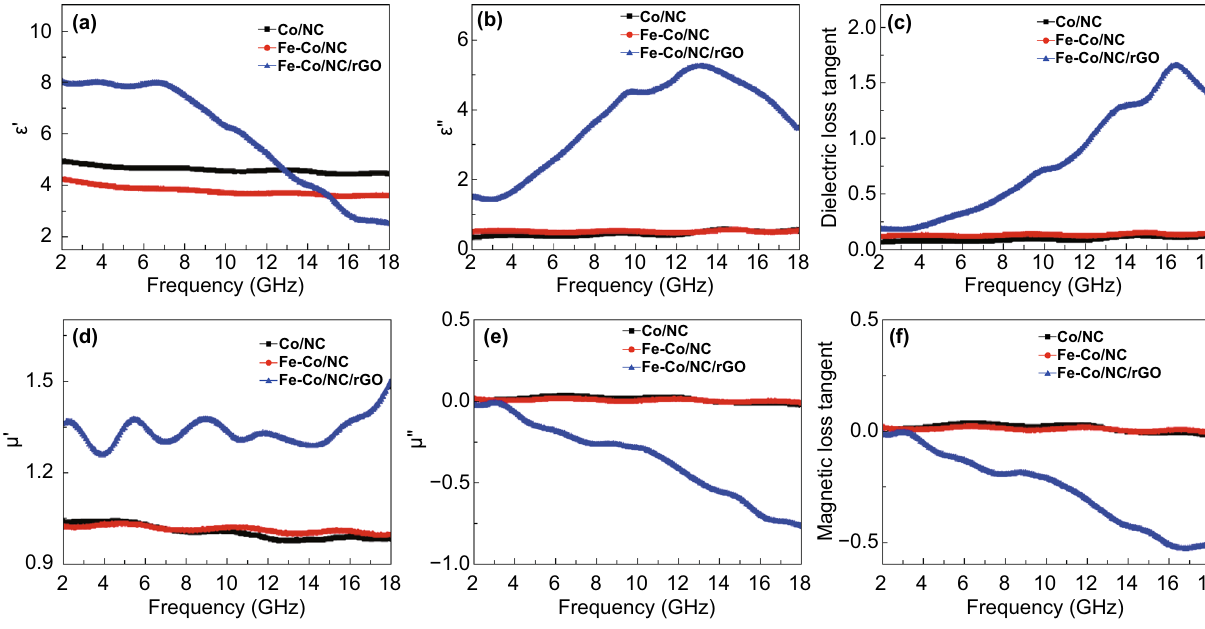
Fig. 8 a Permittivity real part 𝜀 ′ , b permittivity imaginary part 𝜀 ′′ , c dielectric loss tangent tan δ e , d permeability real part 𝜇 ′ , e permeability imaginary part 𝜇 ′′ , and f magnetic loss tangent tan δ m of Co/NC, Fe–Co/NC, and